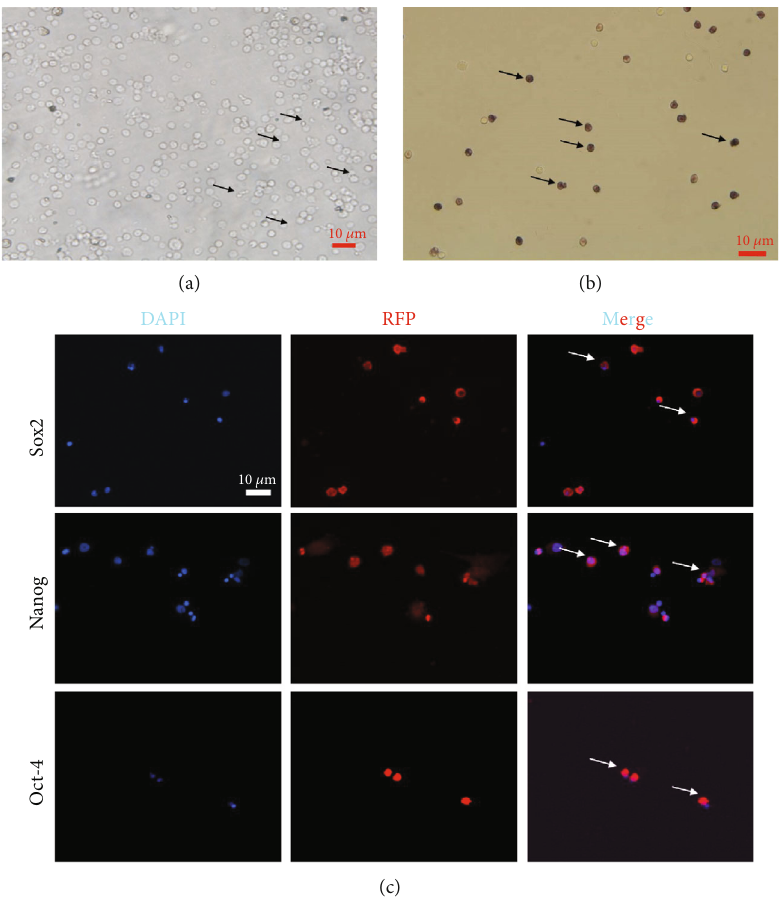
Figure 2: Bone marrow- (BM-) derived very small stem cells (VSELs) retain embryonic stem cell (ESC) characteristics. (a) Rat BM-derived VSELs were obtained by fl ow cytometric sorting. (b) BM-VSELs were assessed for alkaline phosphatase (AKP) activity by staining for AKP. (c) Expression of Sox2, Oct-4, and Nanog in VSELs was assessed by immunostaining with Sox2-, Oct-4-, and Nanog-speci fi c primary antibodies and a Cy3 secondary